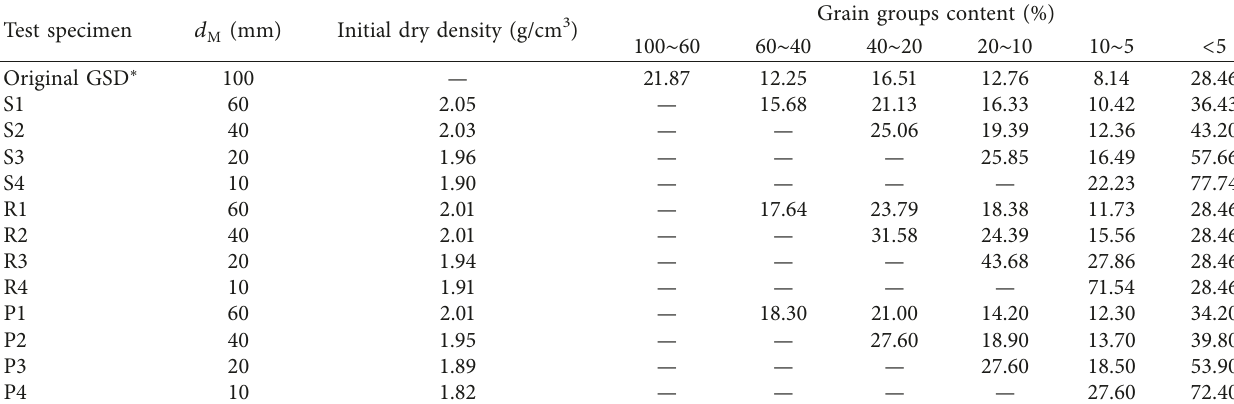
Table 1: Basic property of tested soil and specimens.